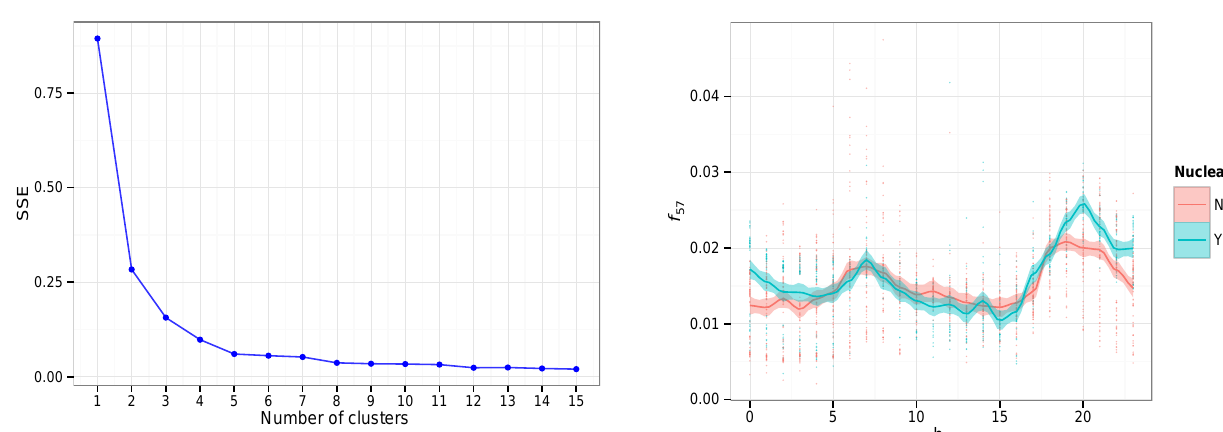
Figure 8. Diurnal variation of the f 57 during the nucleation and non-nucleation days. Solid lines have been calculated using the LOESS smoothing method, and the shaded areas represent the 95% confidence interval. Data include 5 and 51 nucleation and non- nucleation days. The data include weekdays and weekend as no exclusions were applied to increase the statistical